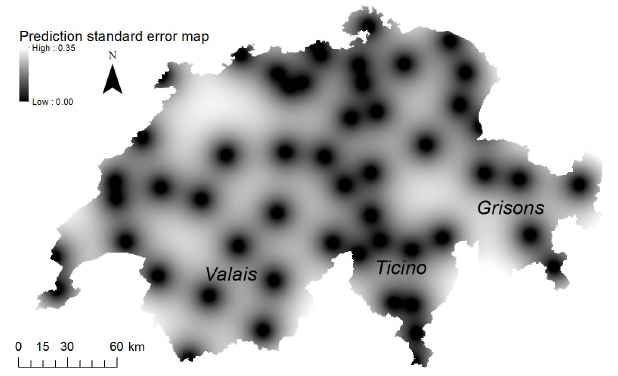
Fig. 4. (R)USLE R -factor map (MJmmha − 1 h − 1 yr − 1 ) of Switzer- land resulting from regression-kriging interpolation of 71